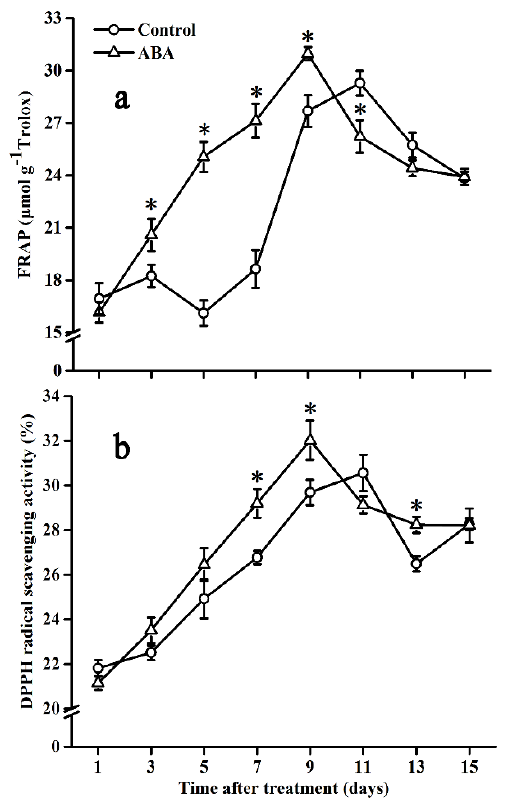
Figure 7. Effect of ABA on total antioxidant capacity FRAP (a) and DPPH radical scavenging activity Figure 7. E ff ect of ABA on total antioxidant capacity FRAP ( a ) and DPPH radical scavenging activity (b) in the tomato during storage at 20 °C. Vertical bars represent the standard deviation (SD, n = 3). ( b ) in the tomato during storage at 20 ◦ C. Vertical bars represent the standard deviation (SD, n = 3). Asterisks (*) represent significant differences ( p < 0.05) between the ABA and control treatments. Asterisks (*) represent significant di ff erences ( p < 0.05) between the ABA and control